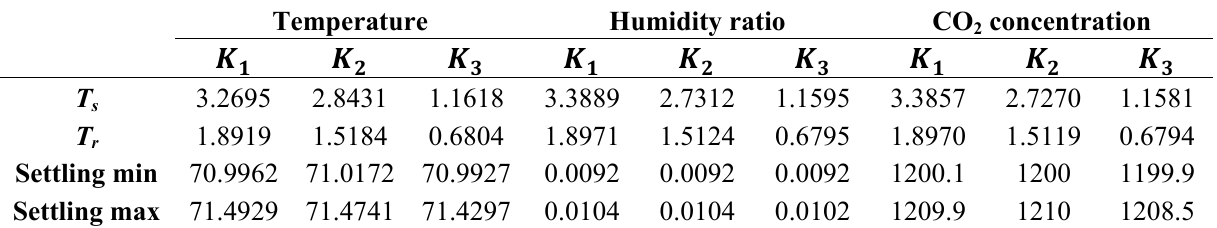
Table 3. Control performance metrics of the pole placement controller.